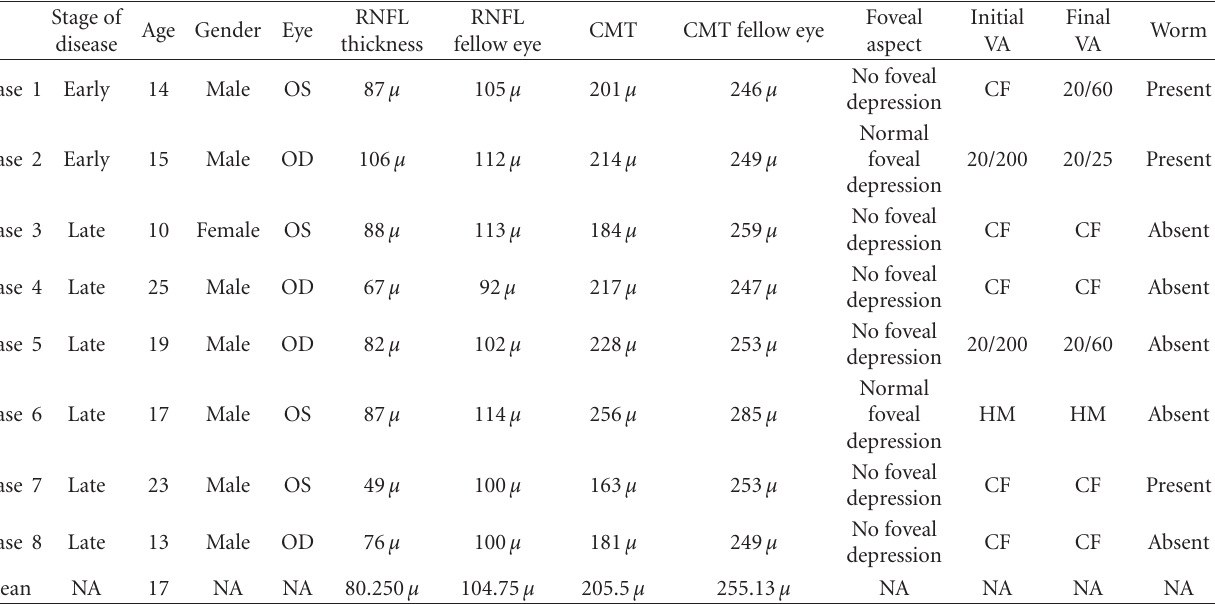
Table 1: Clinical data of patients with DUSN and SD-OCT